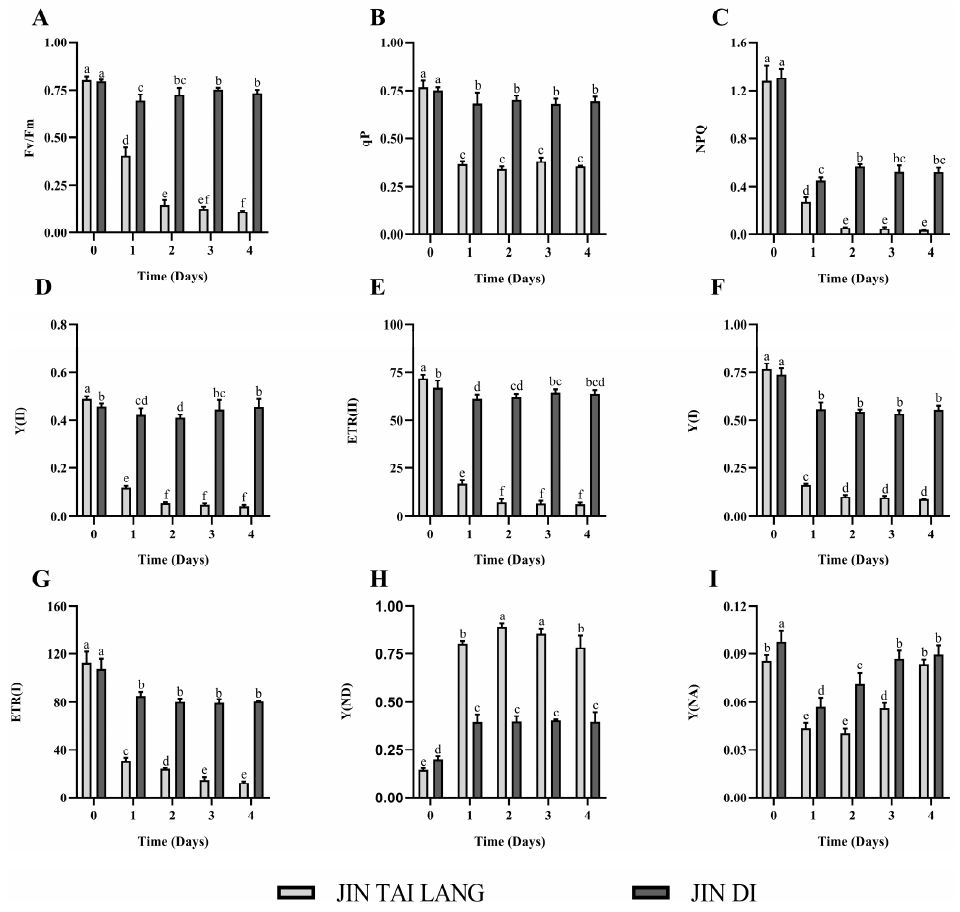
Figure 5. Changes in the leaf fluorescence parameters of two melon genotypes seedlings under HTH stress. ( A ), the maximum quantum yield of PSII (Fv/Fm); ( B ), photochemical quenching (qP); ( C ), non-photochemical quenching (NPQ); ( D ), the effective quantum yield of PSII (Y(II)); ( E ), the electron transport rate through PSII (ETRII); ( F ), the quantum yield of PSI photochemistry (Y(I)); ( G ), the electron transport rate through PSI (ETRI); ( H ), the quantum yield of PSI non-photochemical energy dissipation due to donor-side limitation, (Y(ND)); ( I ), the quantum yield of non-photochemical energy dissipation due to acceptor side limitation (Y(NA)). Different letter indicates significant differences according to Duncan’s multiple range test at p < 0.05 using a one-way ANOVA. Values are represented as the means ± SD ( n =